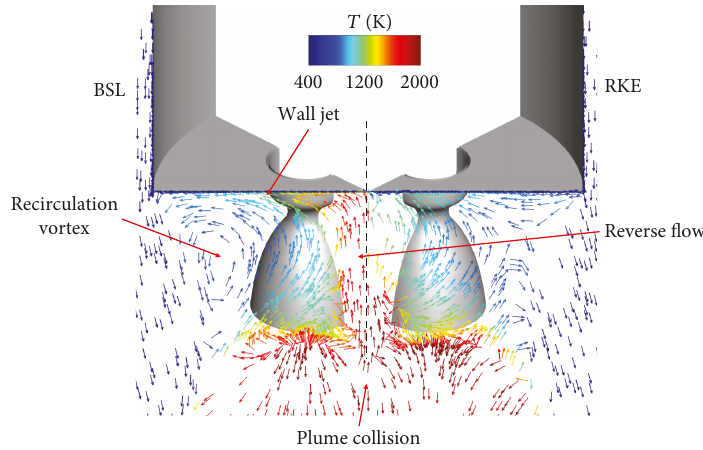
Figure 5: Base fl ow structures for BSL (left half) and RKE (right